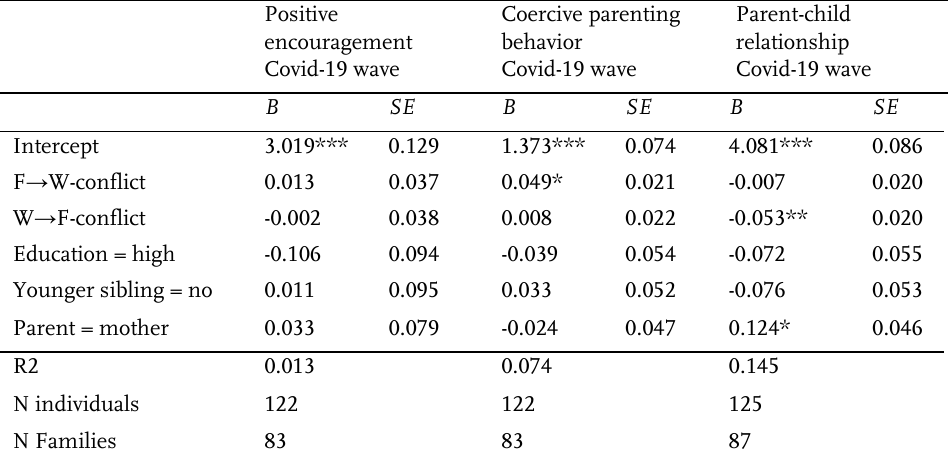
Table A.3a: Multilevel regression models on perceived parenting among mothers and fathers during the Covid-19 wave, without additional